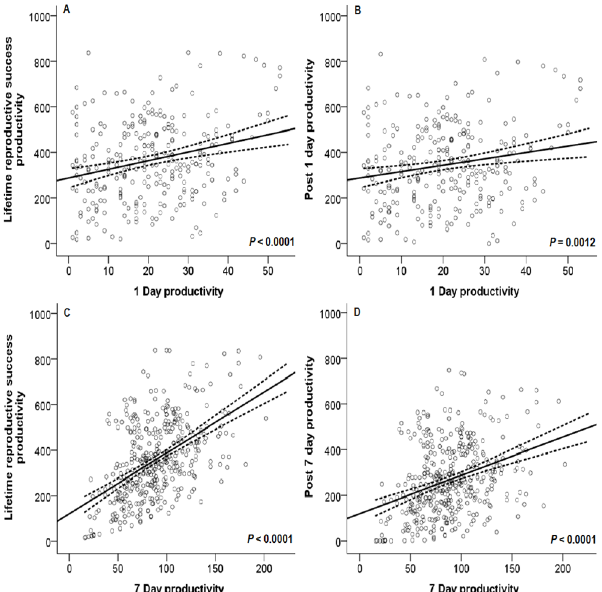
Fig 2. Regression of early short-term reproductive outputs on lifetime reproductive success. Early reproductive success is defined by the number of offspring that eclosed from eggs laid in the first day (A, B) or the first seven days (C, D). These values were compared to a total lifetime reproductive success response variable that either included values of short-term reproductive success (A, C) or that excluded the short-term reproductive success values of one day (B) or seven days (D). Dashed lines represent the 95% CI.